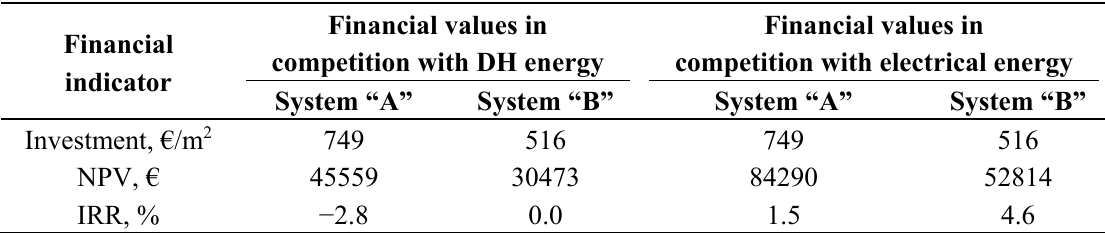
Table 4. Estimated financial indicators for the analysed SHW